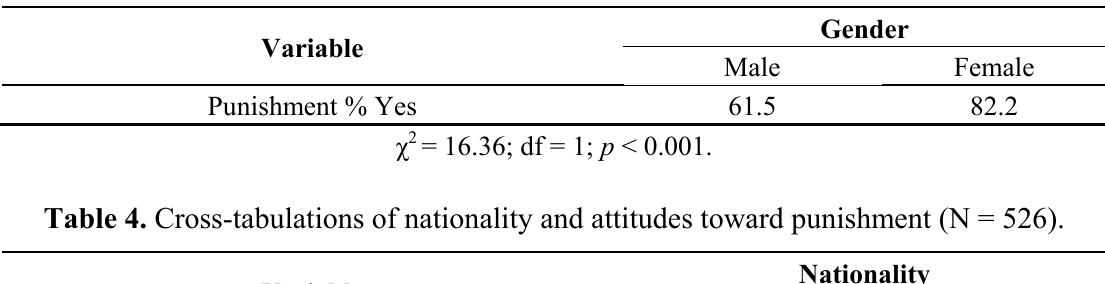
Table 3. Cross-tabulations of gender and attitudes toward punishment (N = 526).